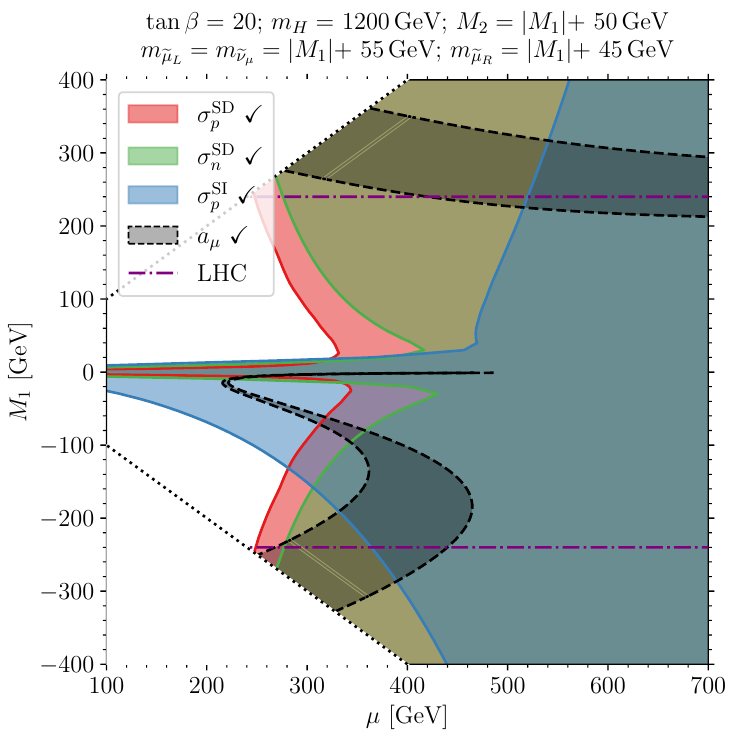
Figure 1 . The colored shades show approximate regions in the µ – M 1 parameter plane allowed by current DM direct detection constraints on the spin-dependent WIMP-proton, spin-dependent WIMP-neutron, and spin-independent WIMP-nucleon cross section for tan β = 20 and values of the slepton, Higgs and Wino mass parameters as indicated in the plot. In the gray areas bounded by the dashed black lines we find a MSSM contribution ∆ a = (25 . 1 ± 5 . 9) × 10 − 10 , explaining the µ value observed by the Fermilab and Brookhaven Muon (g-2) experiments. The dash-dotted purple lines indicate constraints arising from tau-leptons +missing transverse energy(+jet) searches at the LHC, applicable if the mass of the lightest stau is approximately in the middle of the lightest chargino and neutralino masses